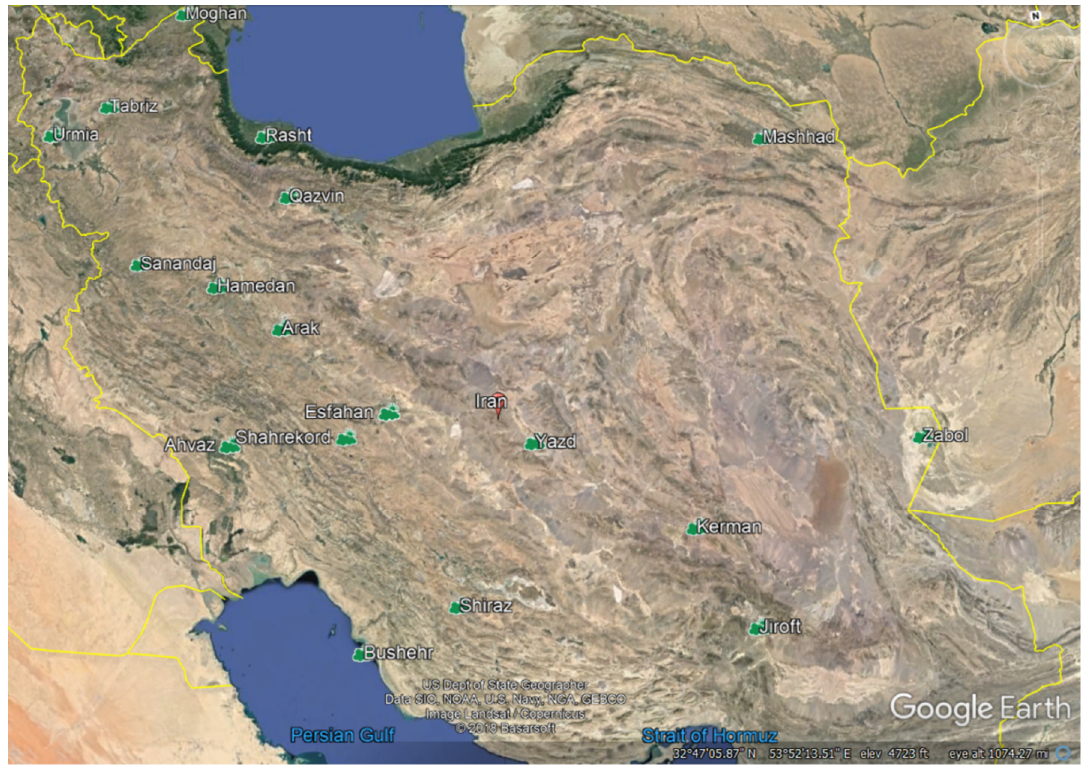
Figure 1. Location of the weather stations.